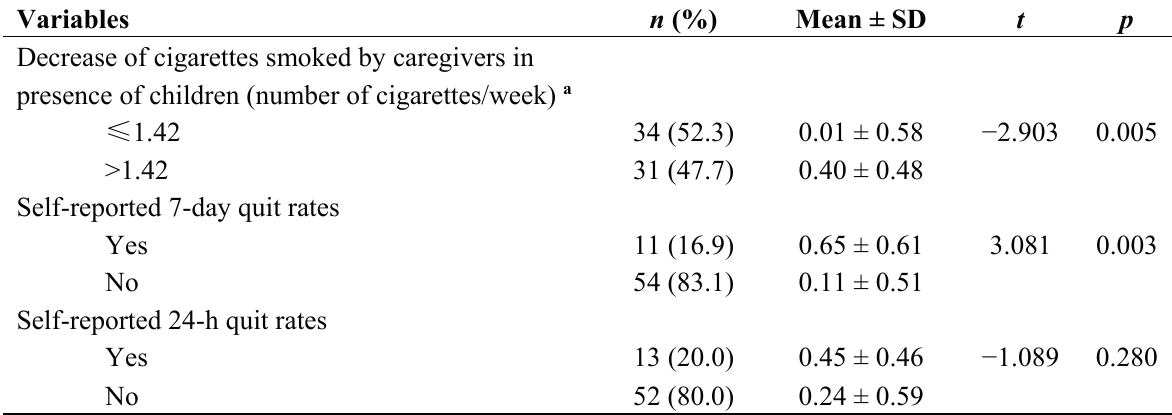
Table 4. Caregiver’s smoking behavior changes and children’s urine cotinine